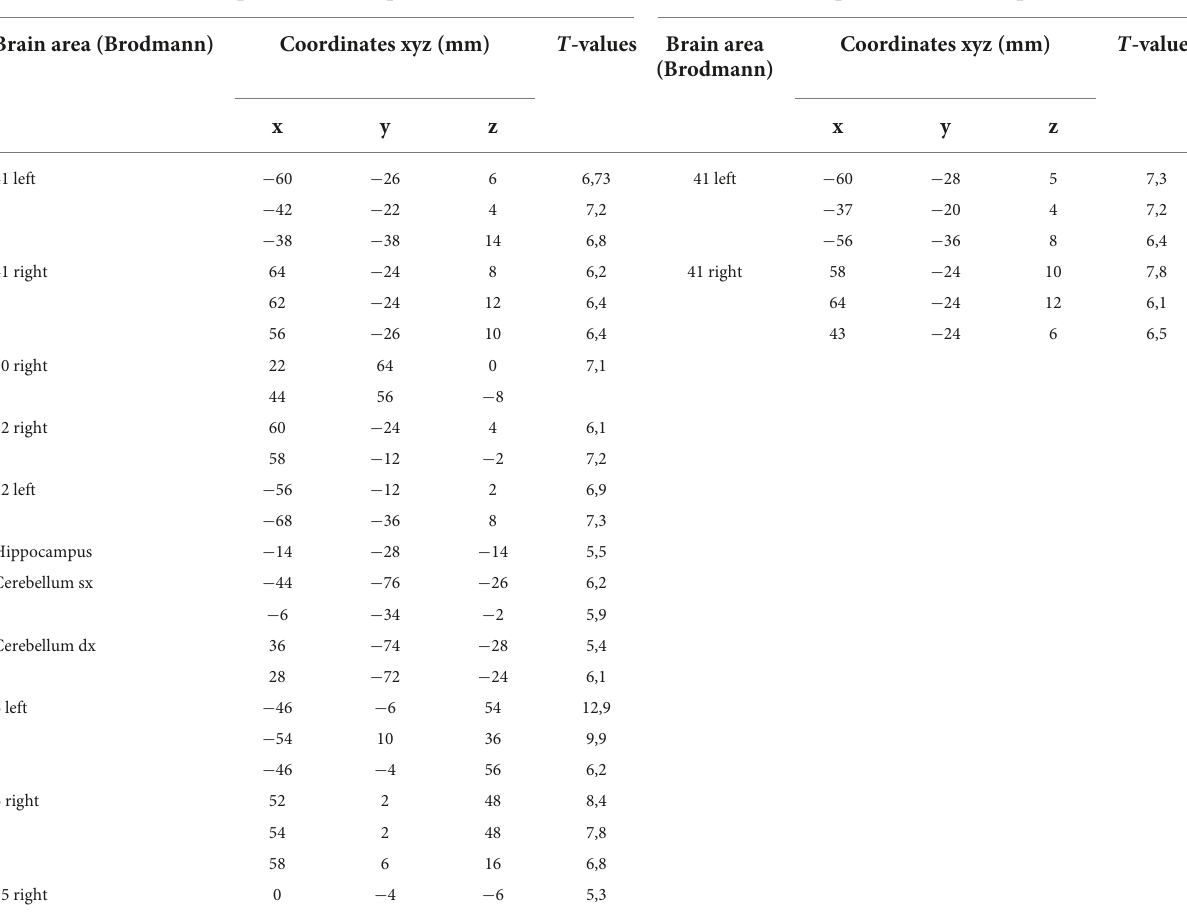
TABLE 6 Functional magnetic resonance imaging (fMRI) activations in participants with misophonia and without misophonia. Participants with misophonia Participants without misophonia Brain area